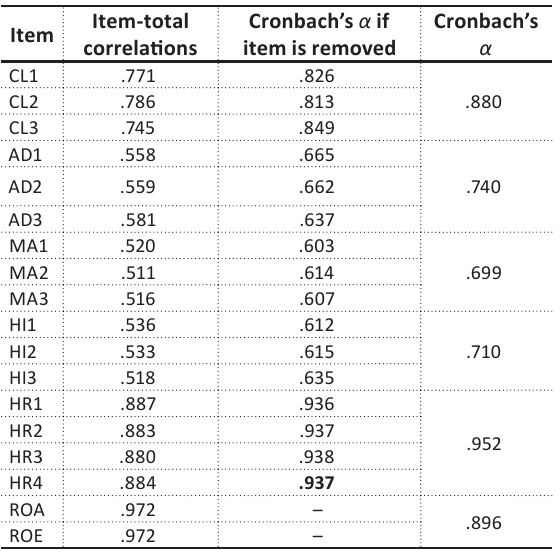
Table 1. Reliability analyses of scales